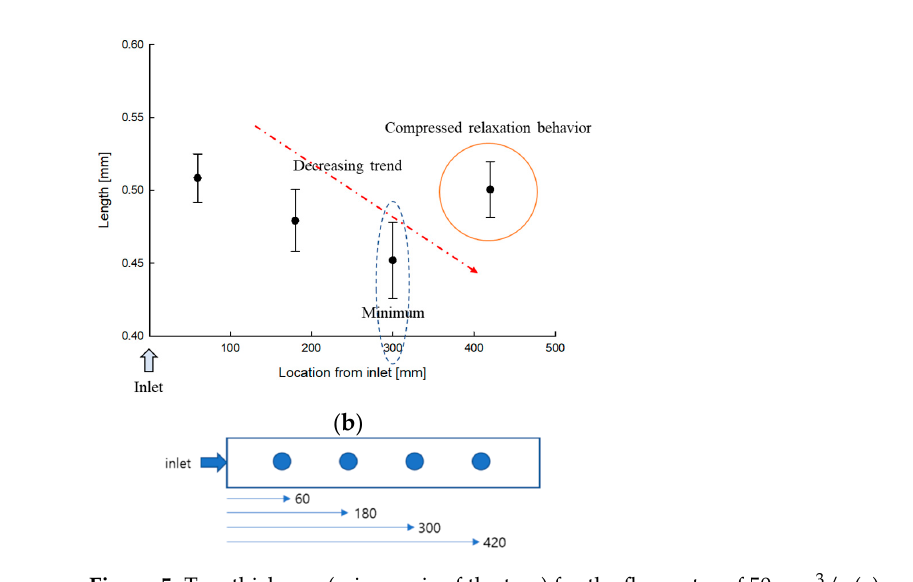
Figure 5. Tow thickness (minor axis of the tow) for the flow rates of 50 mm 3 /s ( a ) and 200 mm 3 /s ( b ) at the different positions (all dimensions are in mm).